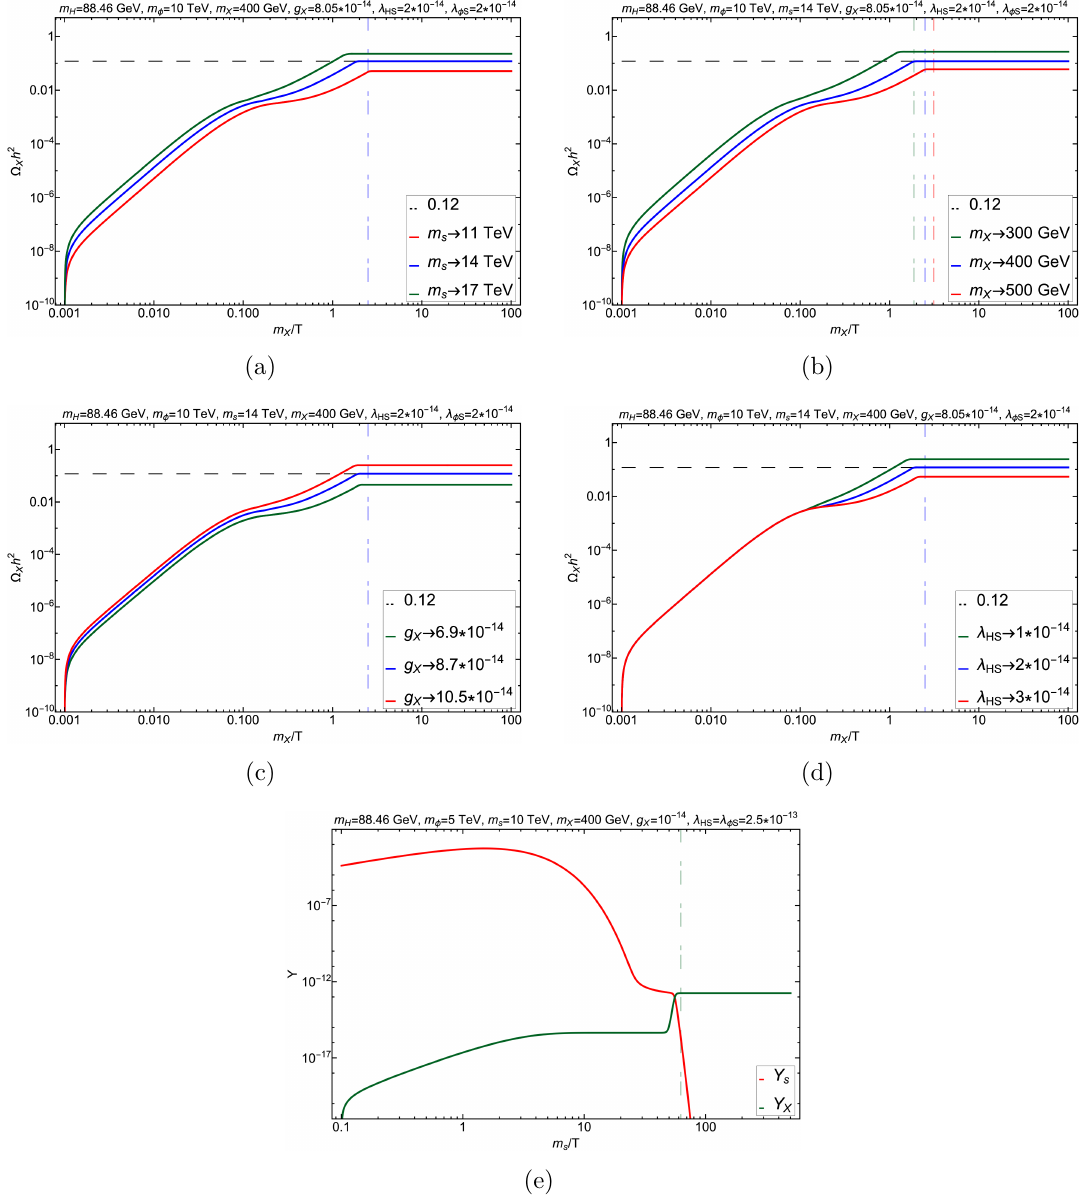
Figure 7 . Freeze-in for X bEWSB in relic density ( Ω X h 2 ) versus x = m X solving BEQ (eq. (4.18)) for the kinematic region 2 m X ≤ m s . Figure 7(a), 7(b), 7(c), 7(d) shows variation with respect to parameters m s , m X , g X , λ HS , having three different values where one provides correct relic, one under abundance and one over abundance. Parameters chosen for the plot are mentioned in figure inset and heading. Horizontal black dashed line shows correct relic density. The vertical dot-dashed lines indicate EWSB. Figure 7(e) shows late decay contribution of s to freeze-in of X bEWSB, obtained by solving cBEQ (eq. (A.1)) using